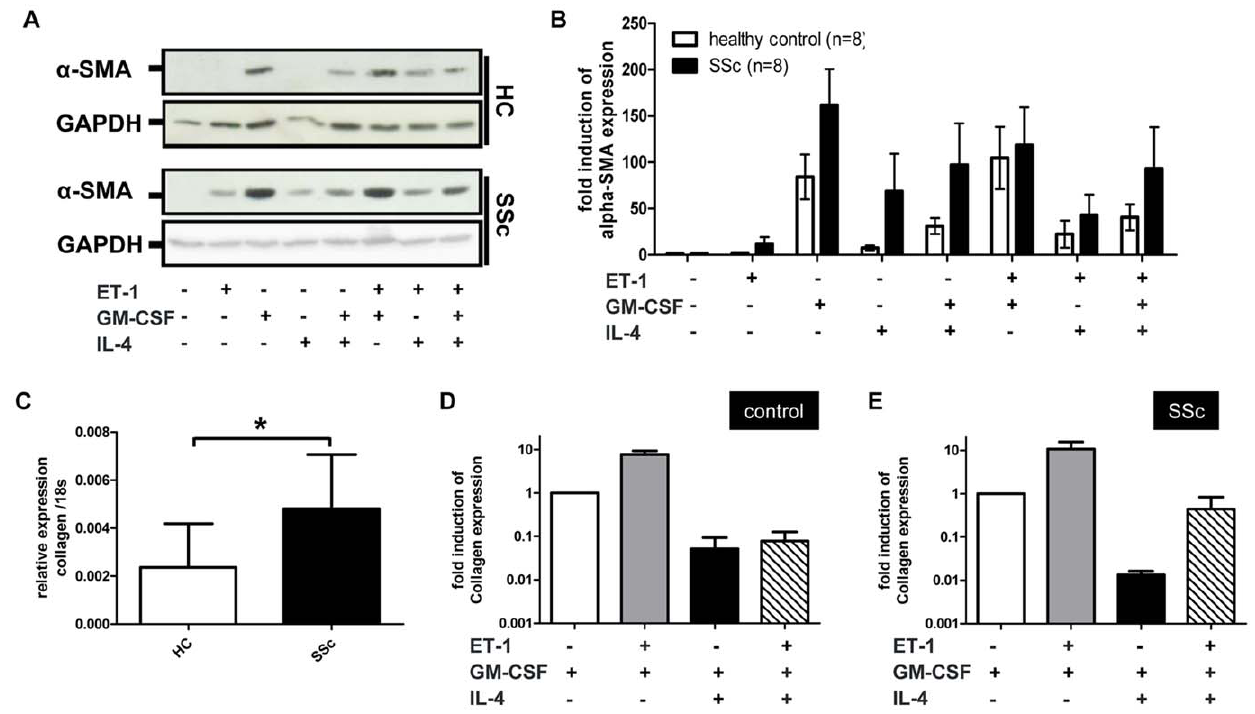
Figure 2. Patient monocytes need less stringent stimulation to upregulate a -SMA. A) Monocytes from healthy controls or SSc patients were cultured for 14 days with GM-CSF, IL-4 or ET-1. a -SMA levels were detected by Western blot analysis. GAPDH was used as loading control. B) Quantification of Western blots from 8 patients and 8 healthy controls showed stronger expression of a -SMA in SSc monocytes compared to healthy controls despite no significant difference could be detected. C) qPCR analysis of the procollagen expression in GM-CSF treated monocytes from healthy controls (HC) (n=4) or SSc patients (n=8). Data were normalized to expression of 18S. (p=0.481). D) and E) Monocytes from HC (n=4) and SSc patients (n=3) were treated with various combinations of GM-CSF, IL-4 and ET-1. Procollagen expression was measured by qPCR. Data were normalized to expression of 18S. The concentration of ET-1 in all experiments was 100 ng/ml. * Statistically significant (P-value , 0.05).